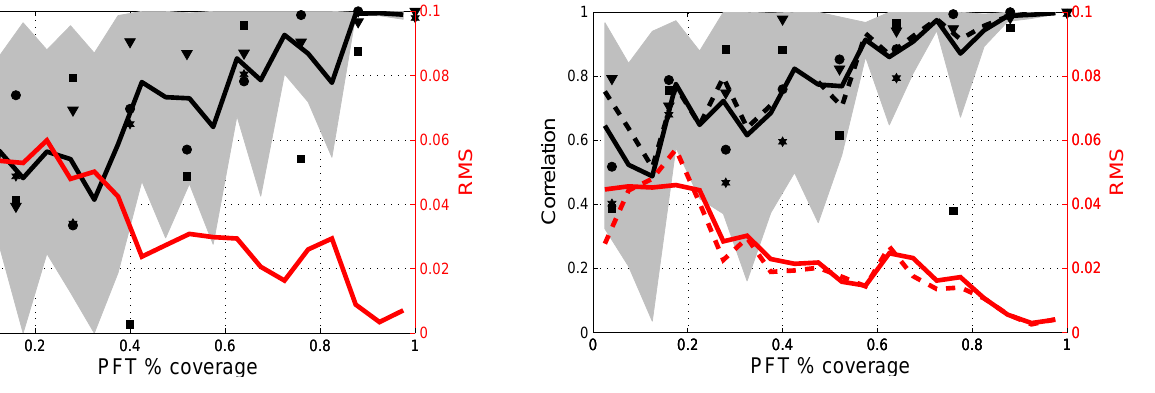
Fig. 7. Same as Fig. 6, but for a 5 × 5 (solid) and 7 × 7 (dashed)